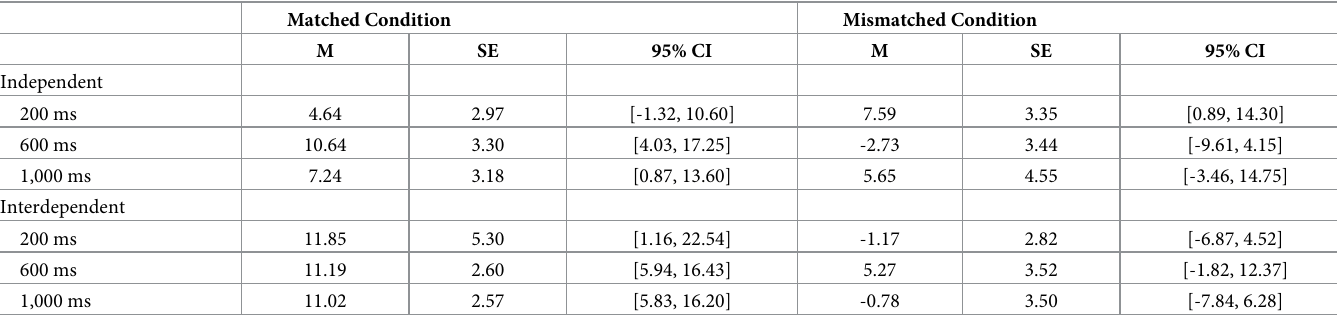
Table 7. Cueing effect indices for East Asian